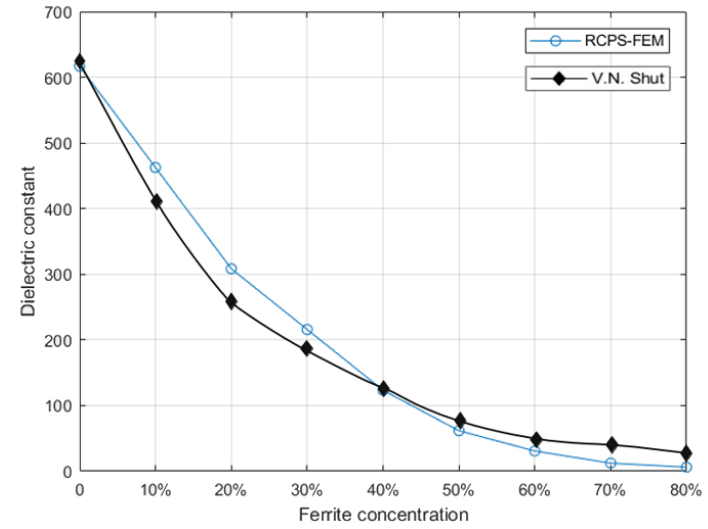
Figure 8. Dielectric permittivity of composites versus ferrite concentration.